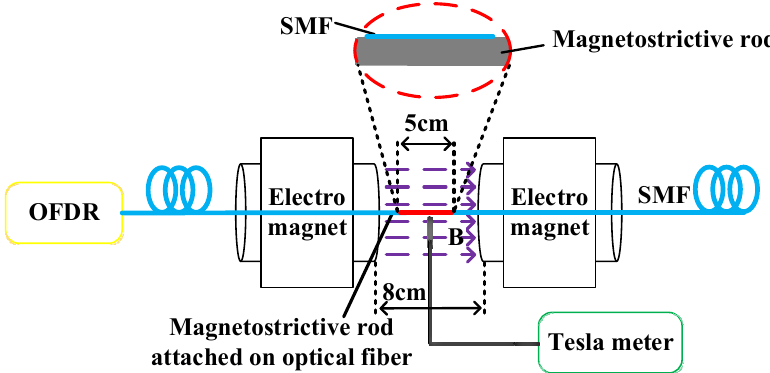
Figure 2. Schematic diagram of the experimental setup.